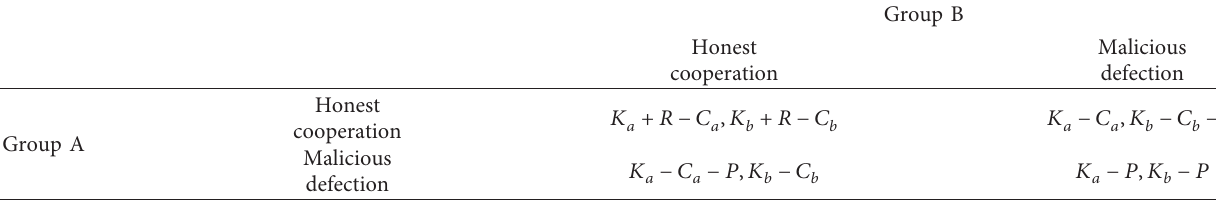
Table 1: Game strategy matrix.